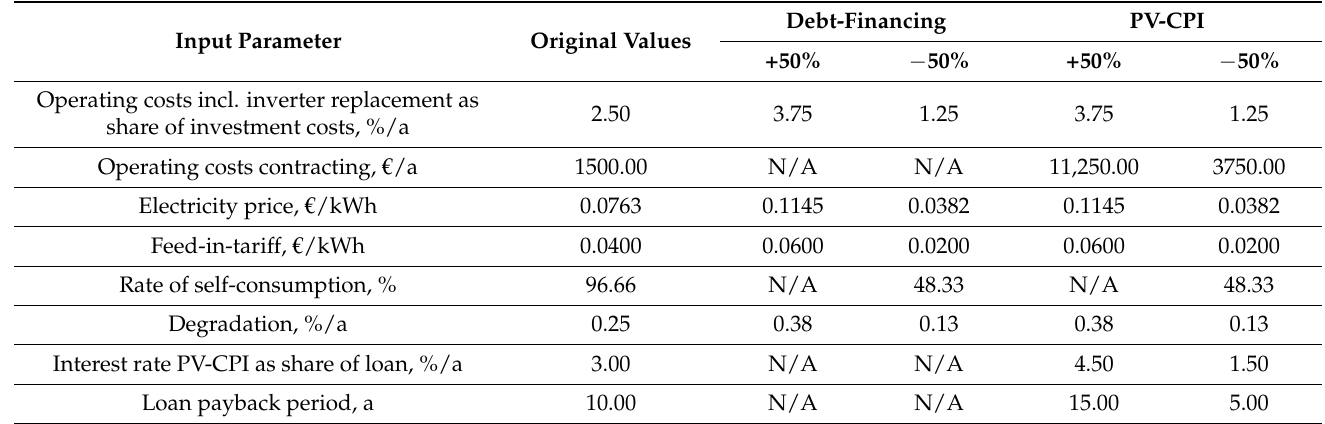
Table 2. Input parameters’ sensitivity